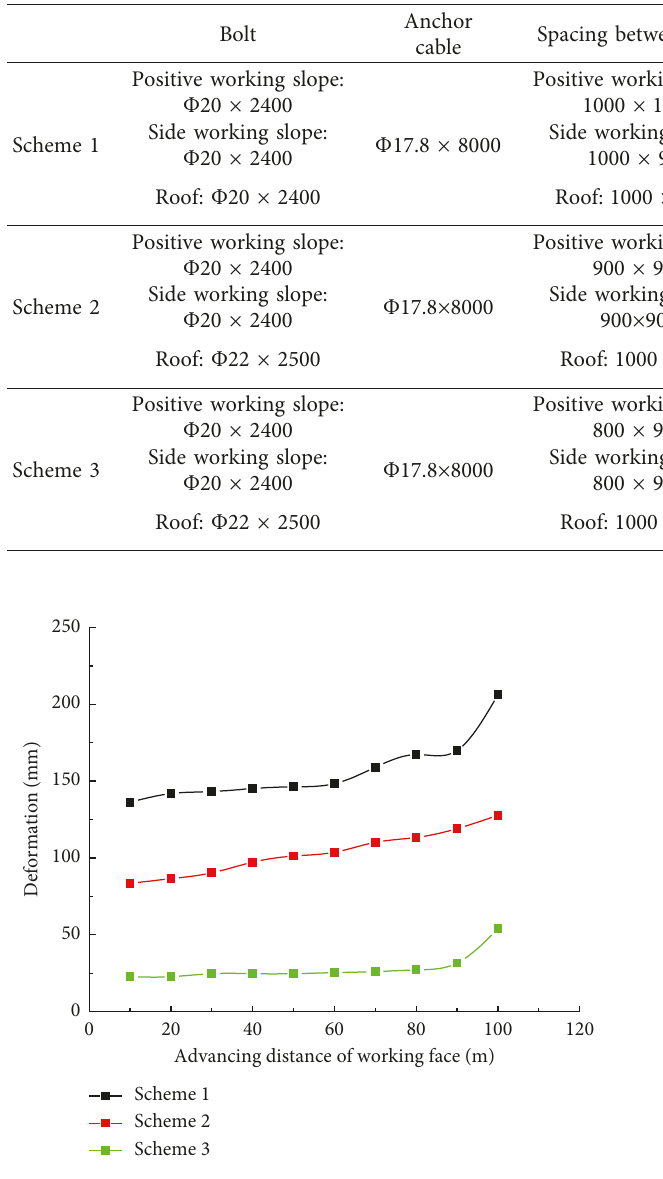
Table 2: Supporting scheme.